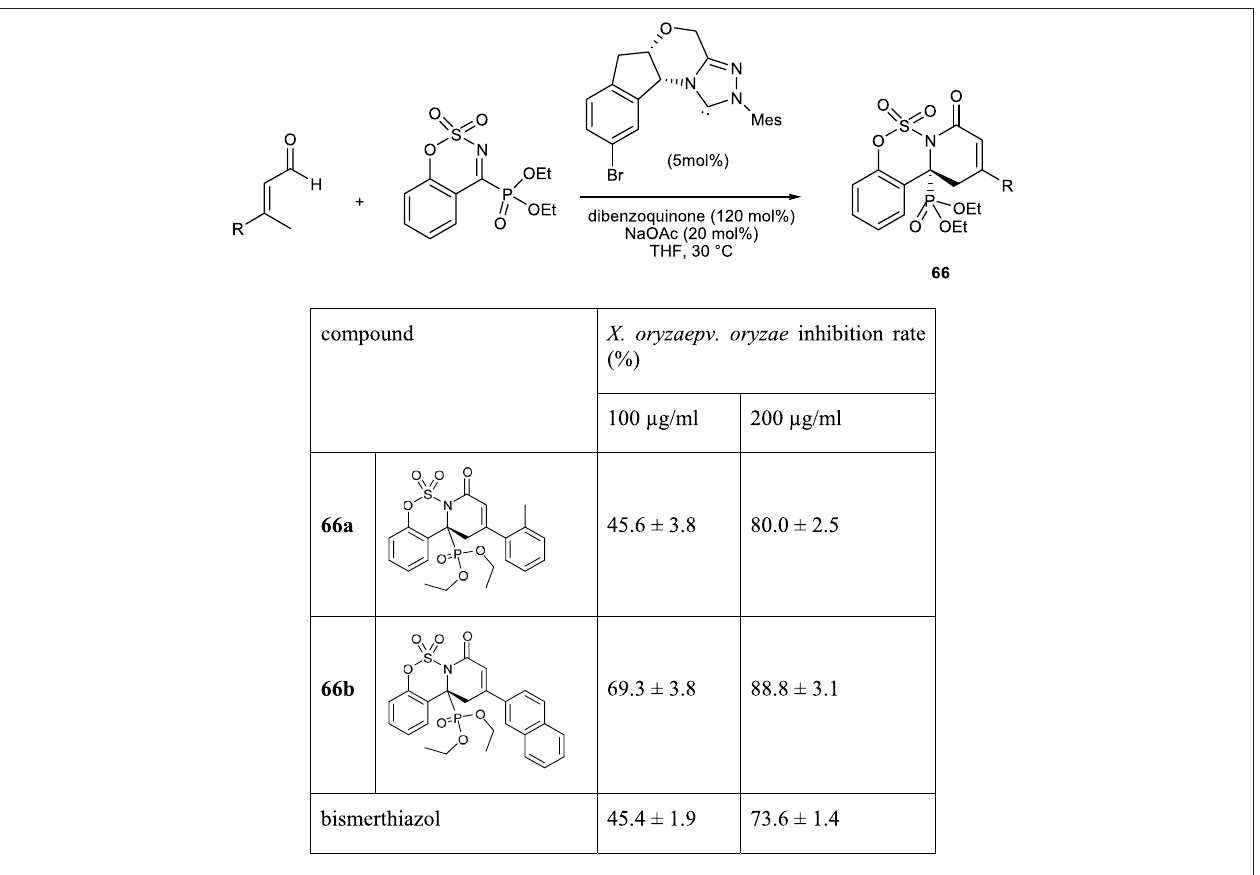
FIGURE 9 | Structure of the compound 66